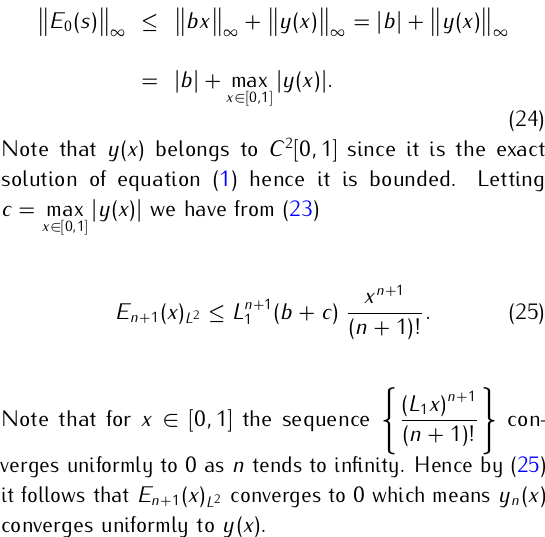
Table 1. (VIM) applied to Bratu’s problem for the case λ